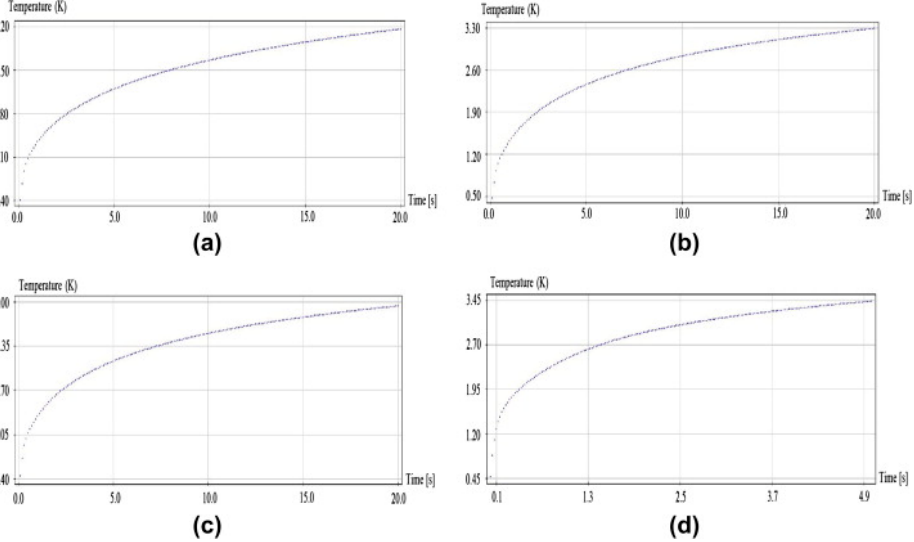
Figure 15. Paraffin/nano-graphite phase change temperature. (Reprinted with permission from ref. [22]. Copyright 2013 Applied Energy).